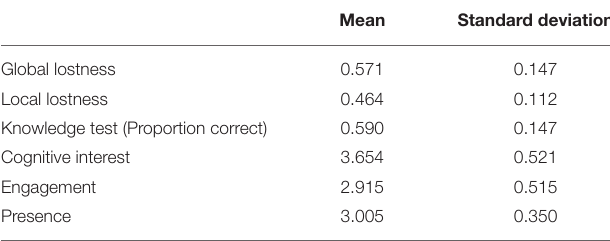
TABLE 2 | Lostness, knowledge, and in-game experience questionnaire means and standard deviations from the first study.